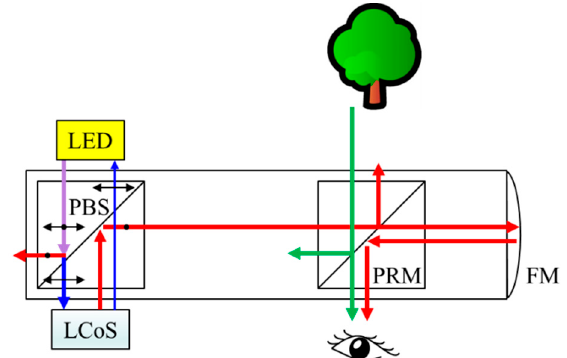
Figure 12. The schematic of LCoS based AR-HUD optical system. BLU: backlight unit; PBS: polarizing beam splitter; PRM: partially-reflective mirror; FM: focusing mirror; blue lines: p-polarized light; red lines: s-polarized light; purple lines: p and s polarized light.